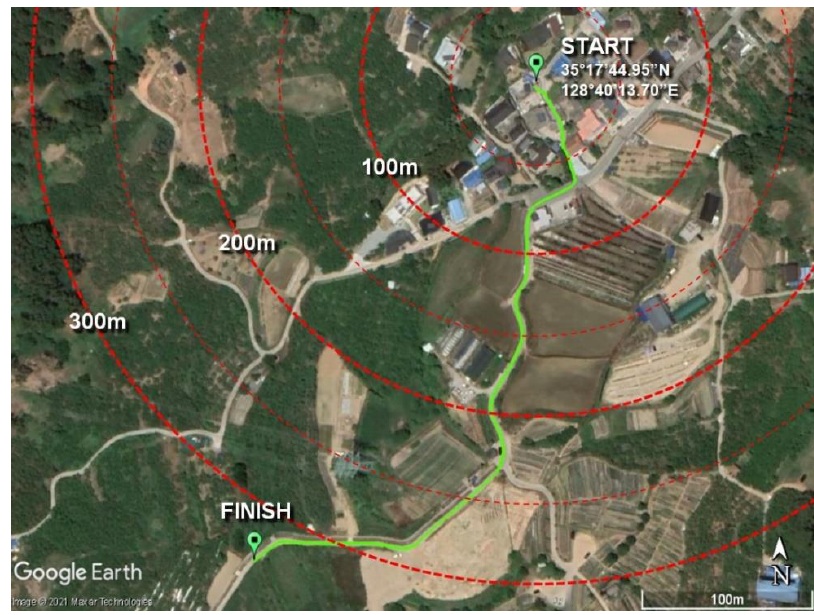
Figure 10. The location of the PV junction box monitoring system and the travel route of the RX module.